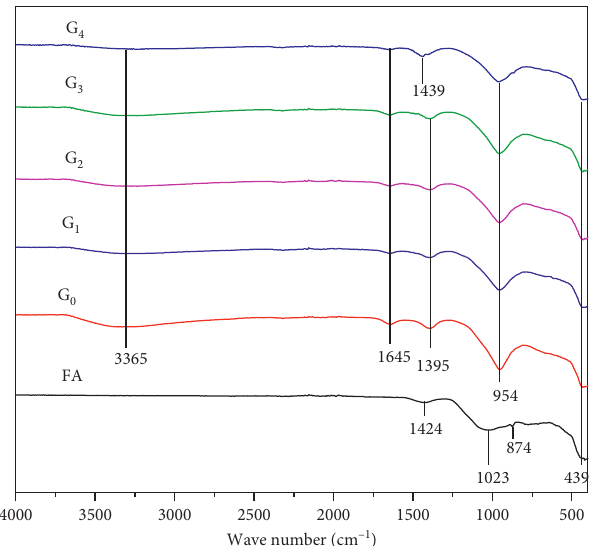
Figure 4: FTIR spectra of fly ash and geopolymer matrices cured at room temperature with different ratio of NaOH and